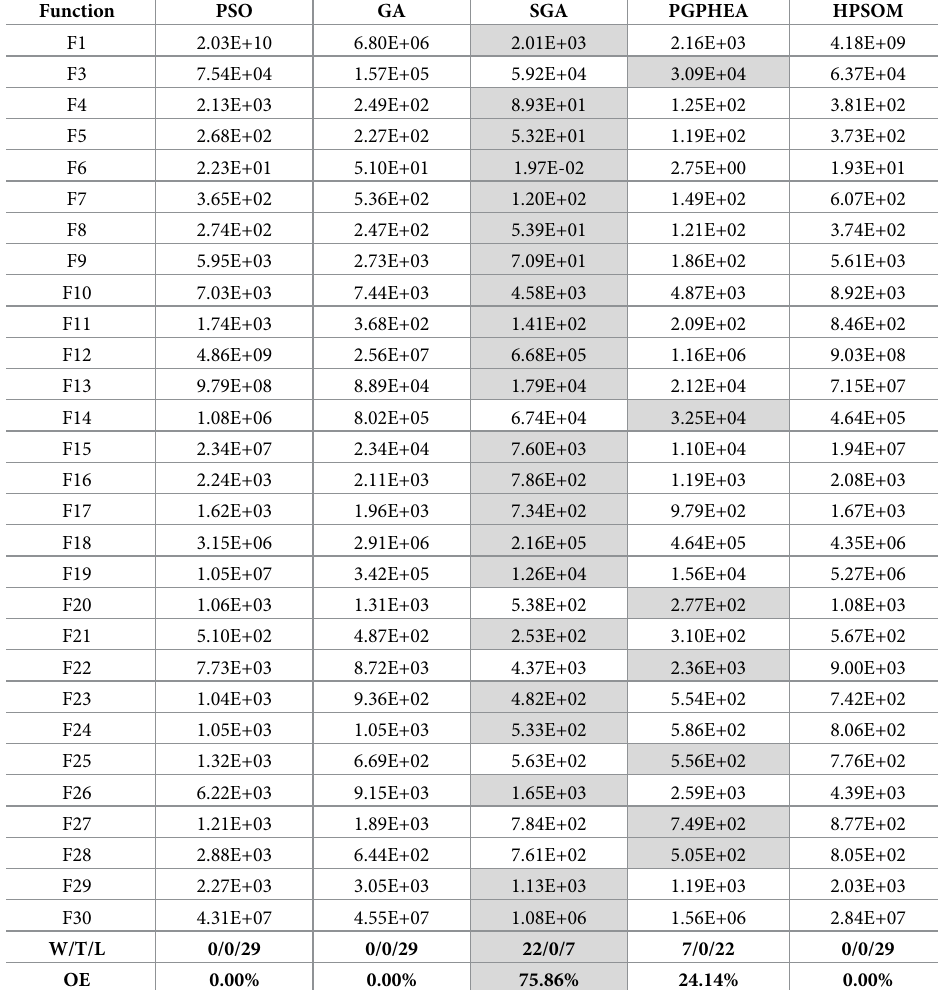
Table 7. Comparison of average error in finding the global optimum for CEC 2017